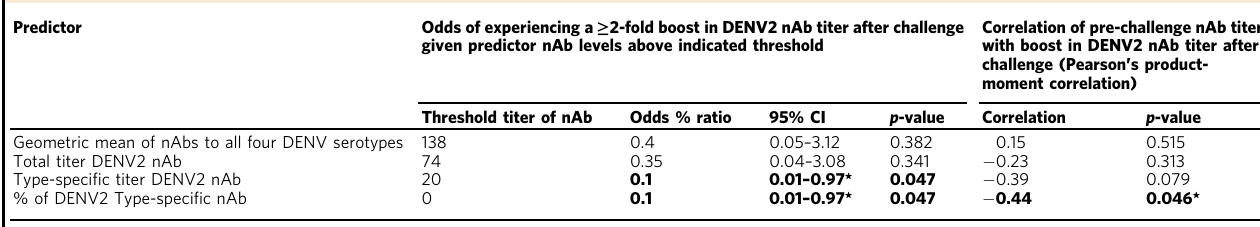
Table 1 Immune correlates analysis of TV003-induced antibodies and sterilizing immunity upon DENV2 challenge. Predictor Odds of experiencing a ≥ 2-fold boost in DENV2 nAb titer after challenge Correlation of pre-challenge nAb titer given predictor nAb levels above indicated threshold with boost in DENV2 nAb titer after challenge (Pearson ’ s product- moment correlation) Threshold titer of nAb Odds % ratio 95% CI p -value Correlation p -value Geometric mean of nAbs to all four DENV serotypes 138 0.4 0.05 – 3.12 0.382 0.15 0.515 Total titer DENV2 nAb 74 0.35 0.04 – 3.08 0.341 − 0.23 0.313 Type-speci fi c titer DENV2 nAb 20 0.1 0.01 – 0.97* 0.047 − 0.39 0.079 % of DENV2 Type-speci fi c nAb 0 0.1 0.01 – 0.97* 0.047 − 0.44 0.046* All21vaccinatedsubjects( n = 21)werechallenged witha partiallyattenuated strainofDENV26monthsaftervaccination.Sterilizingimmunityisde fi ned as<2-foldincrease(comparedtopre-challenge levels) in DENV2 nAb at day 28 after challenge. Asterisk indicates signi fi cant correlations are in bold. % The odds of experiencing a ≥ 2-fold boost in DENV2 nAb titer post-challenge was estimated by predictor nAb level, thresholded by decile. The threshold for the decile with the most signi fi cant relationship with fold-boost is presented. Thethreshold corresponding to the 20th percentile had the lowest p -value for the predictors: Total DENV2 nAb, TS DENV2 nAb, and % of TS DENV2 nAb. The thresholdcorrespondingtothe 40thpercentilewasmost signi fi cantforthe predictorGeometricmean of nAbtiterstoallfourDENV serotypes.Predictors,geometricmean ofnAb titerstoallfourDENV serotypes and total DENV2 nAb were not associated with a signi fi cant protective effect for any threshold value tested (20th, 30th, 40th, 50th, 60th, 70th, 80th percentiles). Data were analyzed by an exploratory statistical analysis to evaluate the relationship between pre-challenge nAb titer and boost in DENV2 nAb titer post-challenge. The correlation between predictor and outcome variables were evaluated by using pearson ’ s product-moment correlation. The odds ratio analysis of ≥ 2-fold boost in DENV2 nAb titer for those with predictor nAb levels above vs. at or below a speci fi ed threshold were estimated us the mosaic package in